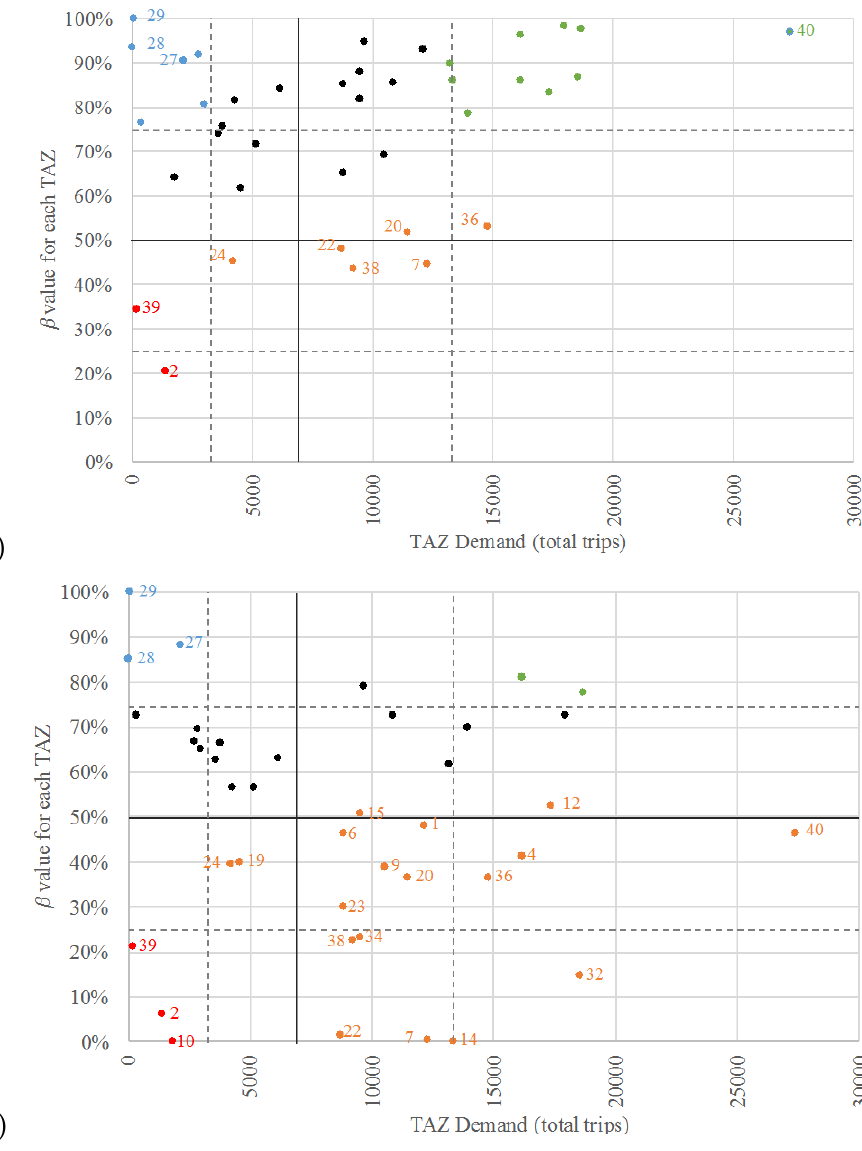
Legend: Solid black lines – Average values; Vertical dashed lines – 2 nd and 3 rd quartiles of TAZ total trips; Horizontal dashed lines – 25% and 75% of cycle coverage network per TAZ Figure 11. TAZ demand vs. β values for (a) criteria 1 with parking removal and (b) criteria 4 without parking